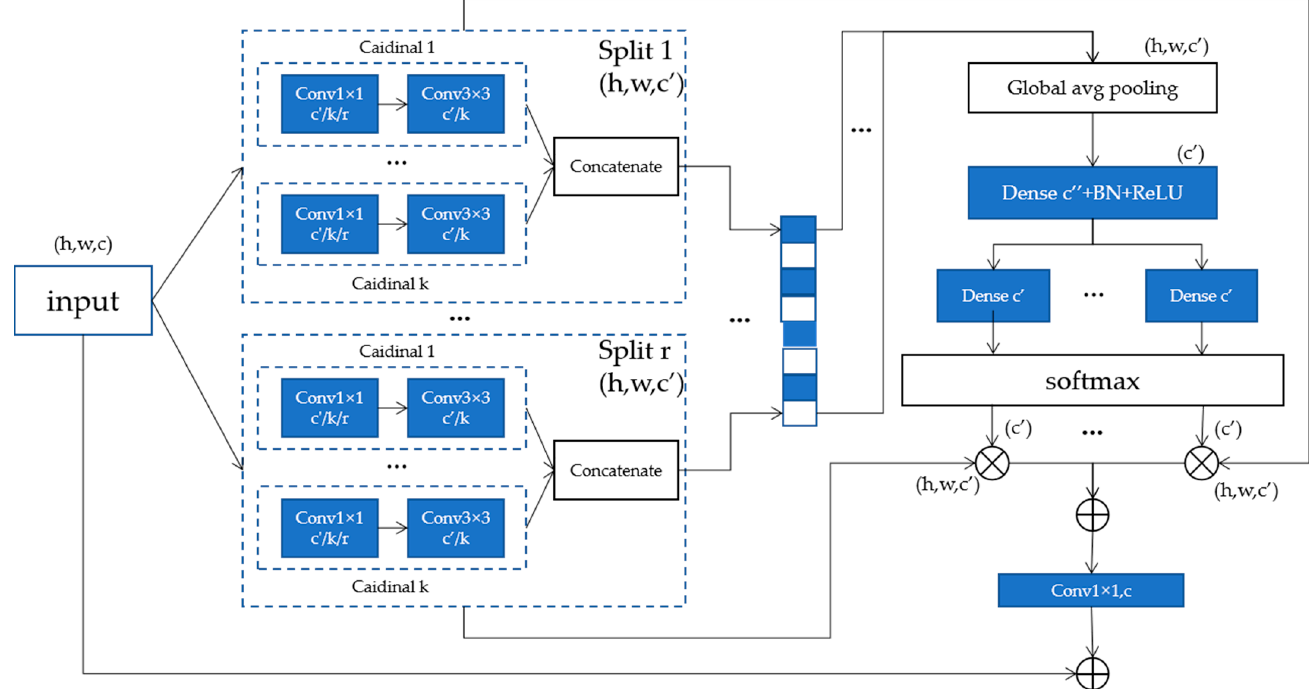
Figure 6. ResNest block.